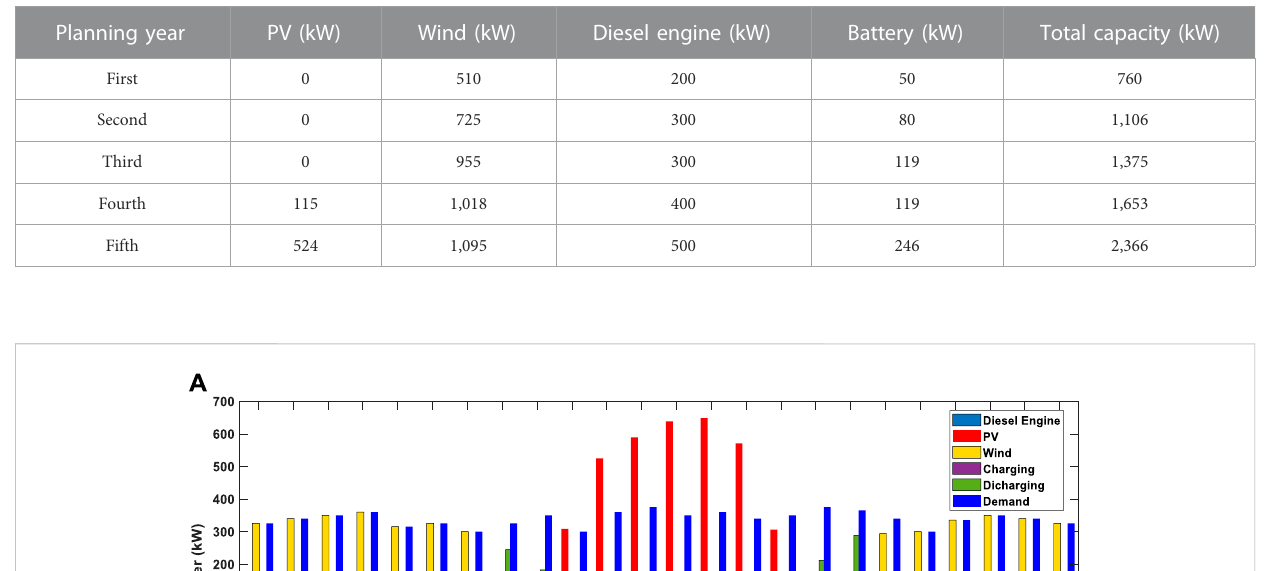
TABLE 6 Planning results for the grid-connected industrial microgrid.